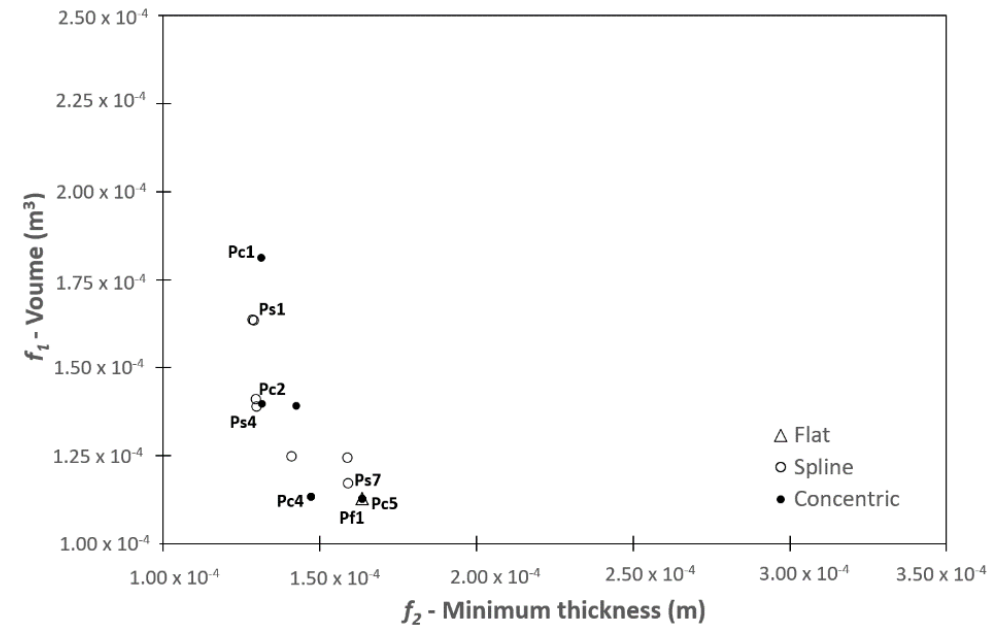
Figure 12. Non-dominated solutions for all cases: flat thickness, spline and concentric spline.